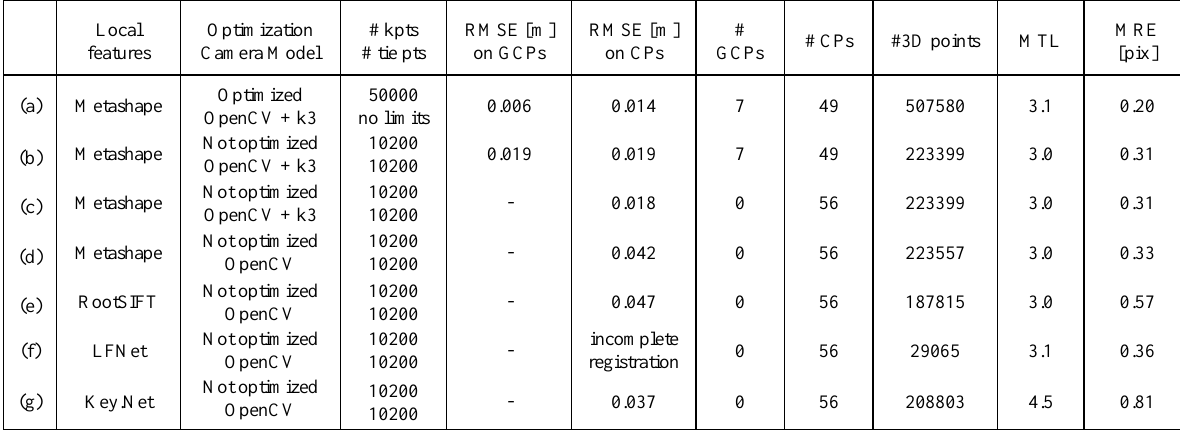
Table 3 . Overall comparison between handcrafted and learning-based tie point extraction methods. In each self-calibrating bundle adjustment the adopted cameral model followed the OpenCV convention (fx, fy, cx, cy, k1, k2, p1, p2).